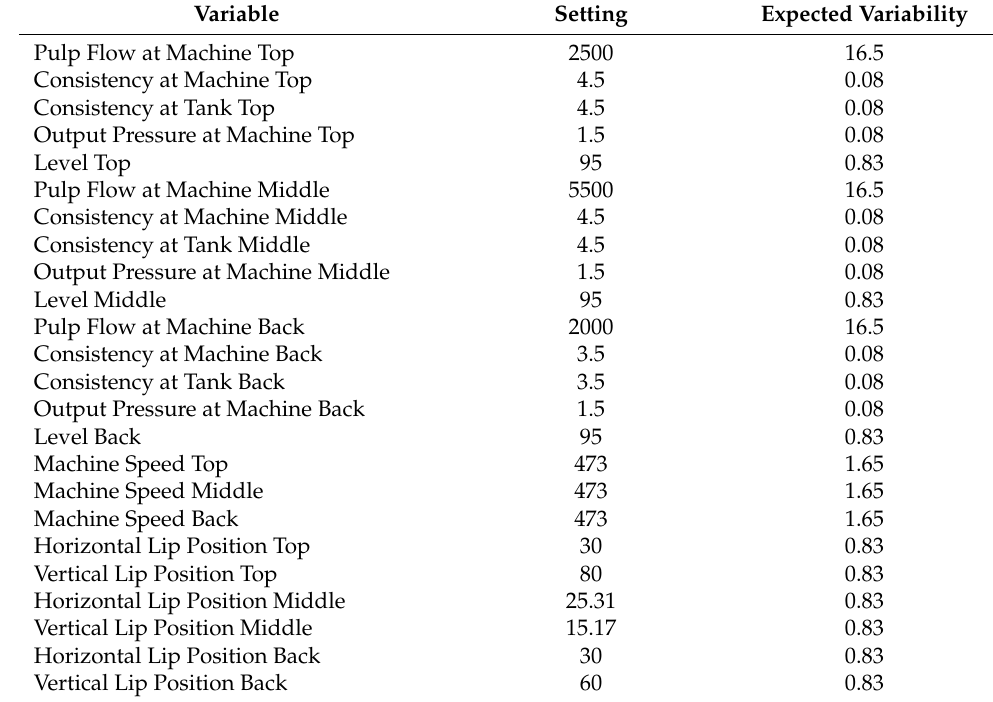
Table 4. Optimal values for the independent variables and expected